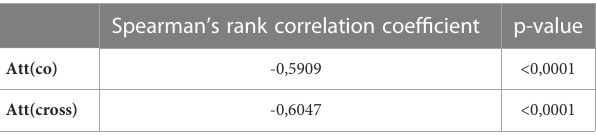
TABLE 4 The results of correlation analysis of optical coef fi cients and brain tissue